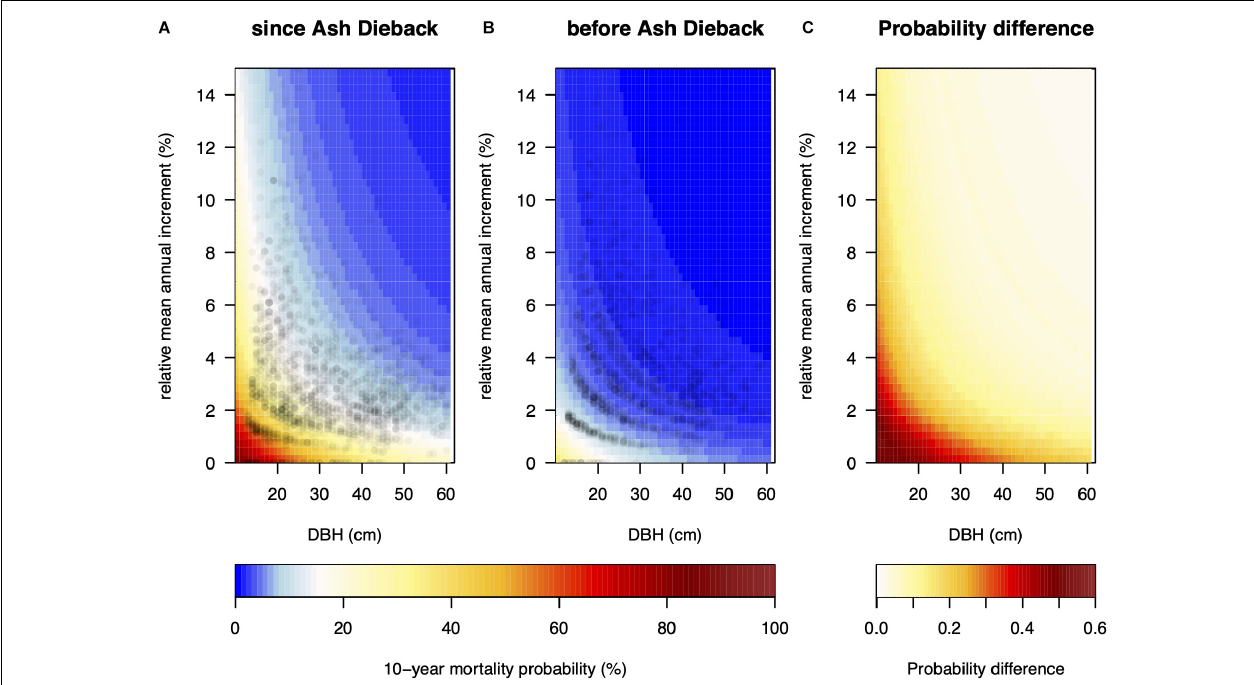
FIGURE 4 | (A) Size and growth-dependent predicted 10-year mortality probability. Fixed variables were set as if the model tree was surveyed in 2019 in a wet forest type, at an elevation of 700 m, slope inclination of 38%, 1,300 mm mean annual precipitation, and first occurrence of Ash dieback in 2008 (i.e., TIMESINCE = 11). Panel (B) shows the same prediction without year of survey and year of first detection of fungal presence with the model preceding the arrival of the fungus in Switzerland. Panel (C) displays the difference between panels (A,B) . Points in panels (A,B) show observed pairs of relative annual basal area increment (relBAI) and diameter at breast height